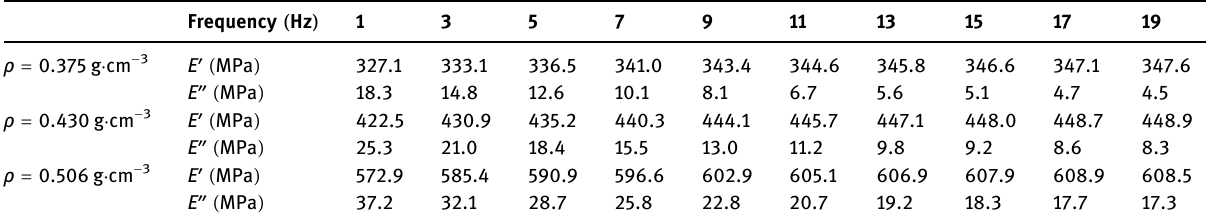
Table 4: Calculation of dynamic viscoelastic modulus Frequency ( Hz )